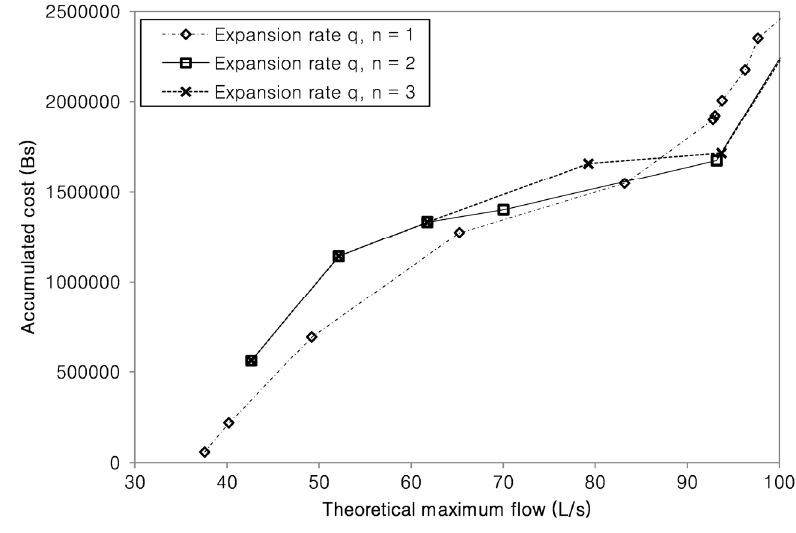
Figure 11. Comparison of cumulative costs depending on the expansion rate used.